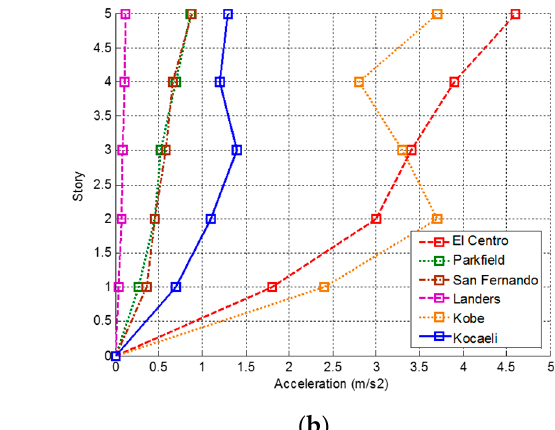
Figure 5. The results of ( a ) peak displacement and ( b ) peak acceleration for different stories of building after changing the story stiffness.